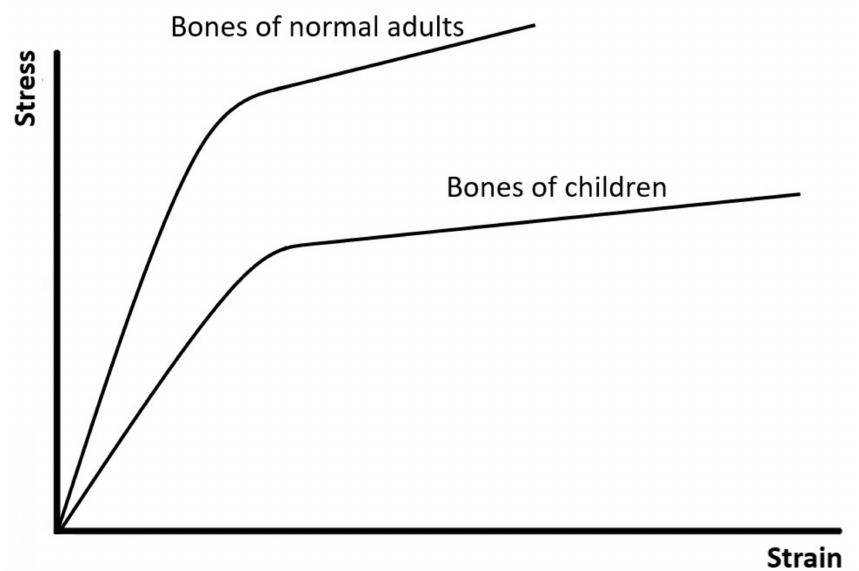
Figure 7. The stress–strain curves of bones of normal adults and children. This figure is adapted from